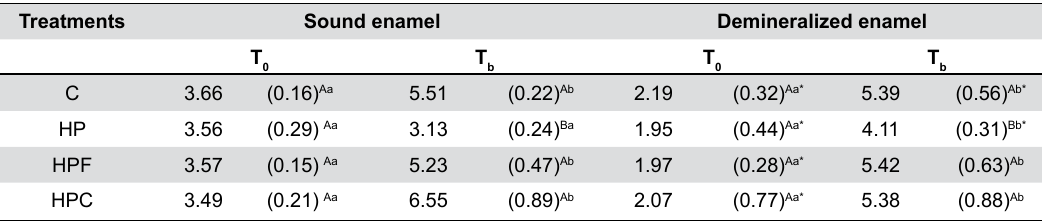
Table 3- Mean values and standard deviations of relative areas of carbonate (CO spectra of sound and demineralized enamel at baseline